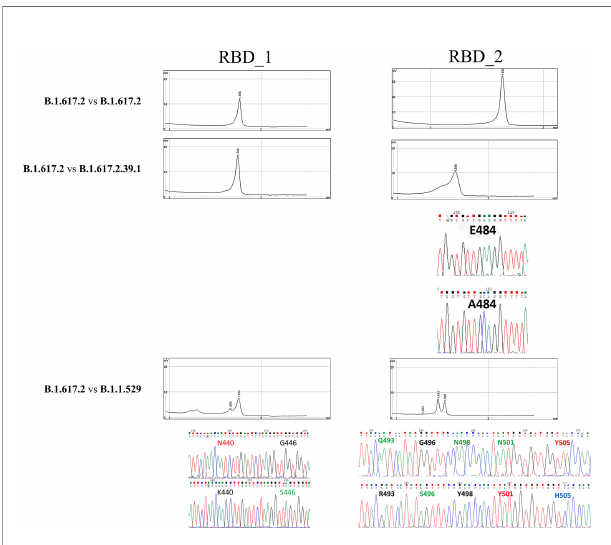
FIGURE 5 | Denaturing High-Performance Liquid Chromatography fi ndings in the blind-label group. Comparison of the reference used (B.1.617.2) against unknown positive samples. Whenever heteroduplexes were found, the sequenced amplicons (chromatograms) are reported, highlighting the nucleotide substitutions and the respective aminoacidic change in the S